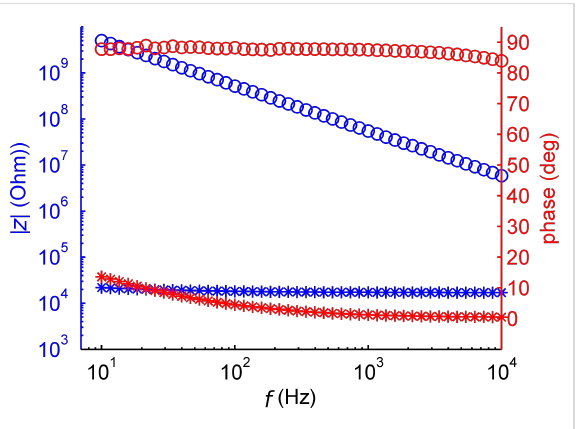
Figure 3: Impedance plot measured across the nanoporous membrane before (stars) and after (circles) lipid bilayer formation. Left axis: Absolute value of the impedance (blue). Right axis: Phase in degrees (red).